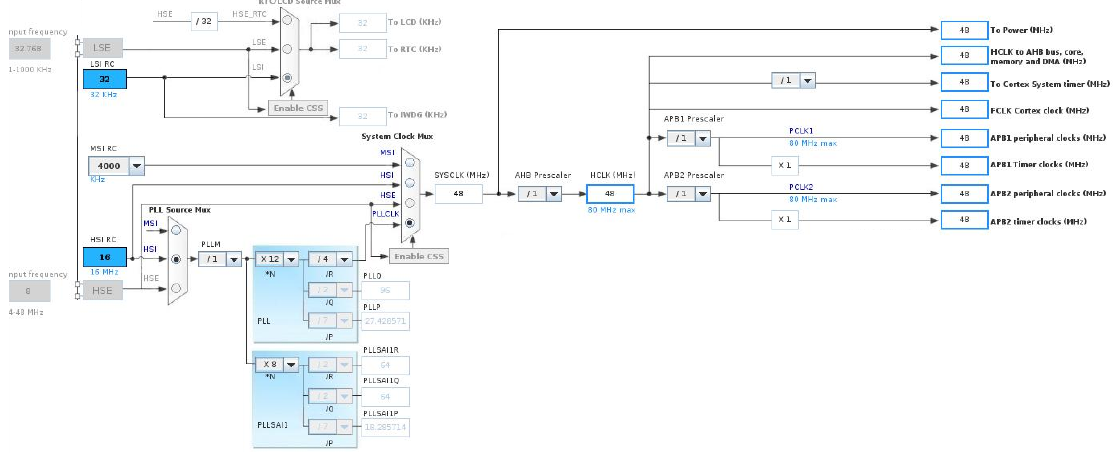
Figure 7. Clock settings for signal generation with